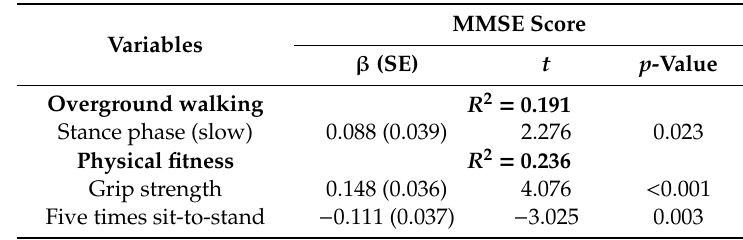
Table 3. Association of gait at three di ff erent speeds and physical fitness variables with global cognitive function in older adults. MMSE Score Variables β (SE) t p -Value Overground walking R 2 = 0.191 Stance phase (slow) 0.088 (0.039) 2.276 0.023 Physical fitness R 2 = 0.236 Grip strength 0.148 (0.036) 4.076 < 0.001 Five times sit-to-stand − 0.111 (0.037) − 3.025